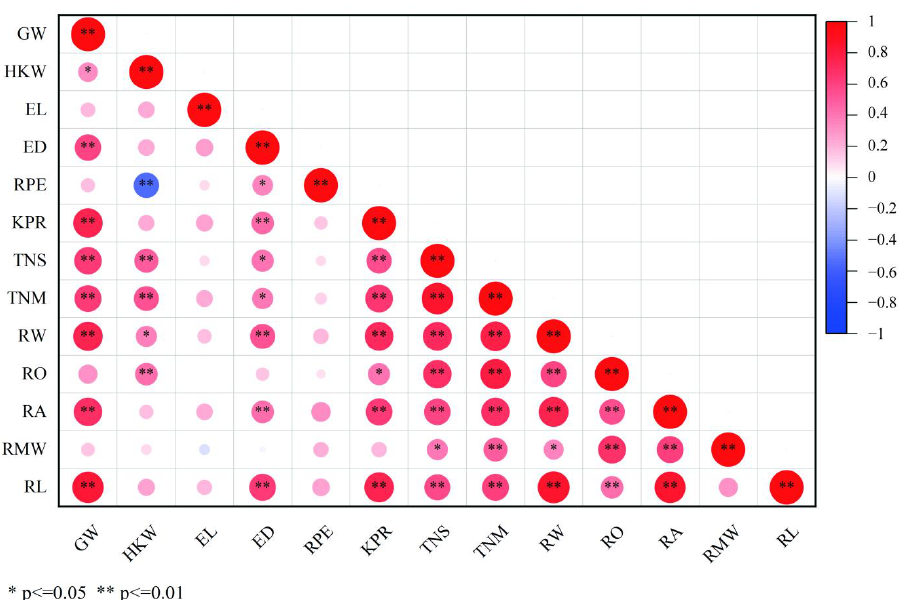
Figure 6. Correlation coefficients between grain yield, N accumulation, and root system traits of six cultivars under three nitrogen (N) conditions. * significant at the 0.05 probability level; ** significant at the 0.01 probability level.GW, Grain weight; HKW, hundred-kernel weight; EL, Ear length; BHL, Bald head length; ED, Ear diameter; RPE, Rows per ear; KPR, Kernels per row; TNS, total N accu- mulation at silking; TNM, total N accumulation at maturity; RW, root weight; RO, root angle open- ing; RA, root surface area; RMW, root maximal width; RL, root length. Yield and N accumulation are significantly related to root angle and root width (Fig- Agriculture 2022 , 12 , 209 ure 8). With the increase of root angle and root width, the yield and N accumulation con- tinue to increase, while their continuous increase cannot further increase yield. On the contrary, too large root width will reduce maize yield and N accumulation. The trends in yield and N accumulation at the three N levels are consistent with the linear + plateau model ( p < 0.05). Results from the model showed that when the root angle reaches 99.53° and 97.39°, the N uptake will reach the plateau value of 2.56 g plant − 1 and 2.11 g plant − 1 in 2019 and 2020, respectively; when the root width reaches 15.18 cm and 14.83 cm, the y N accumulation plateau value will be 2.34 g plant − 1 and 1.90 g plant − 1 in 2019 and 2020, re- spectively. Therefore, when the root angle of cultivars reaches 99.53°, and the root width reaches 15.18 cm, higher yield and N accumulation can be obtained.